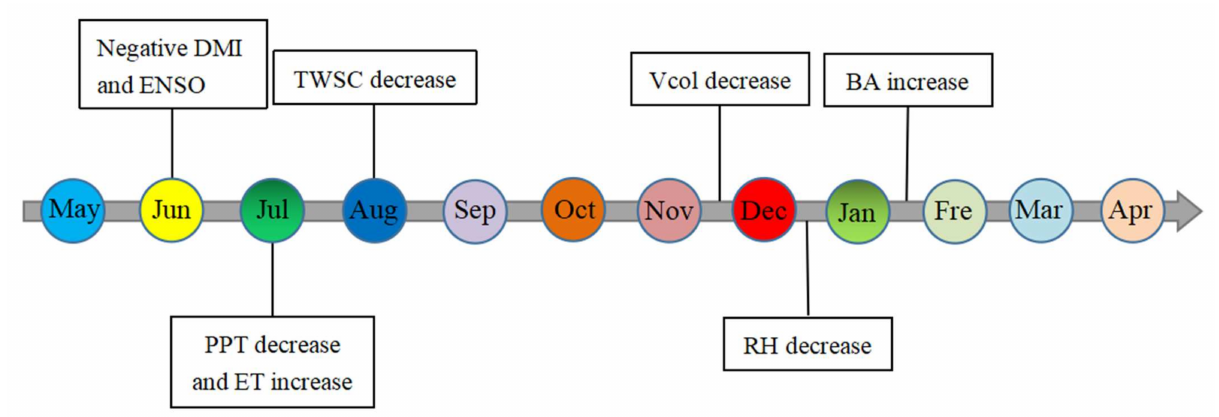
Figure 12. A series of climatic and hydrological changes before forest fires. To further verify the response of GRACE TWSC to climate change before forest fires, high- and low-fire years, respectively. From Figures 13 and 14, we found that there is no significant difference between PPT in high- and low-fire years in region NW and S.